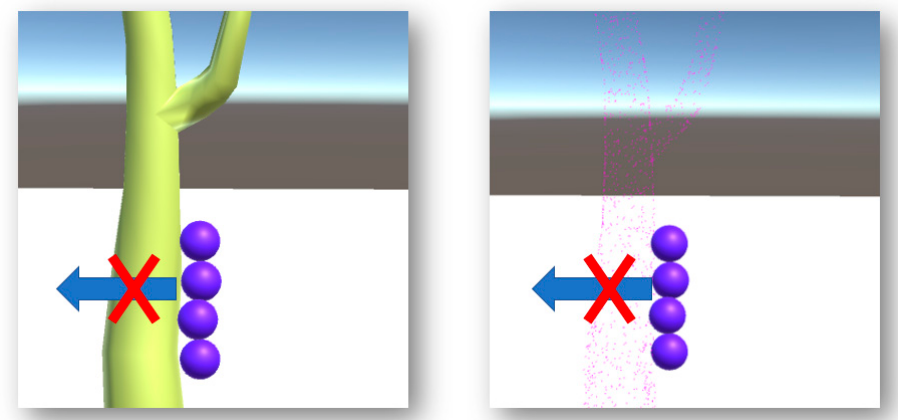
Figure 6. The demonstration of the similar response of VWMs for the solid tree model ( left ) and its corresponding point cloud ( right ).